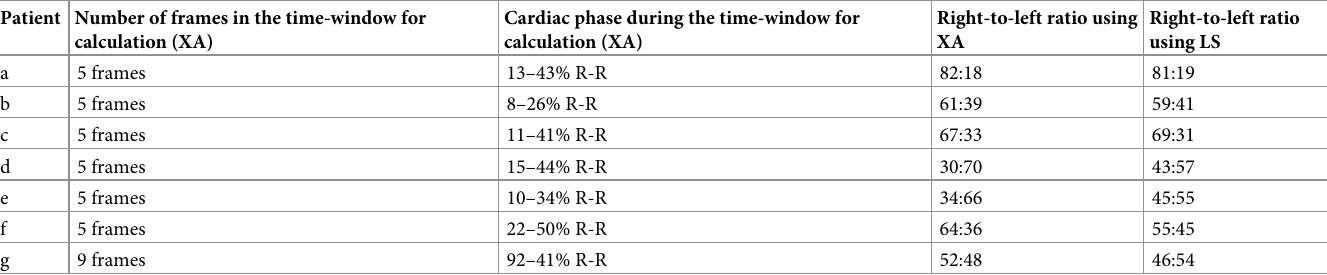
Table 2. Comparison of the right-to-left ratios between X-ray pulmonary angiography (XA) and lung perfusion scintigraphy (LS). Patient Number of frames in the time-window for calculation (XA)